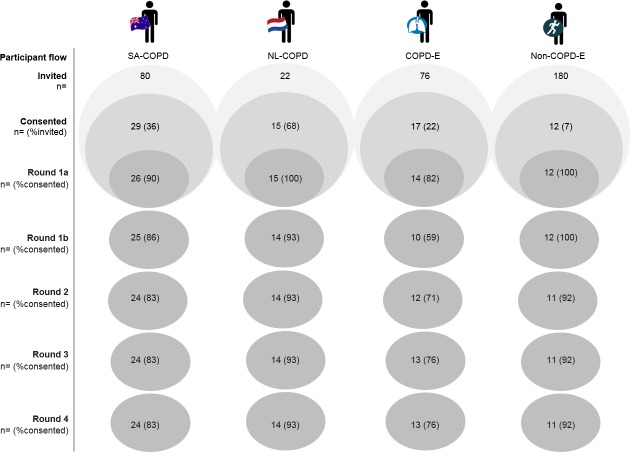
Participant flow.